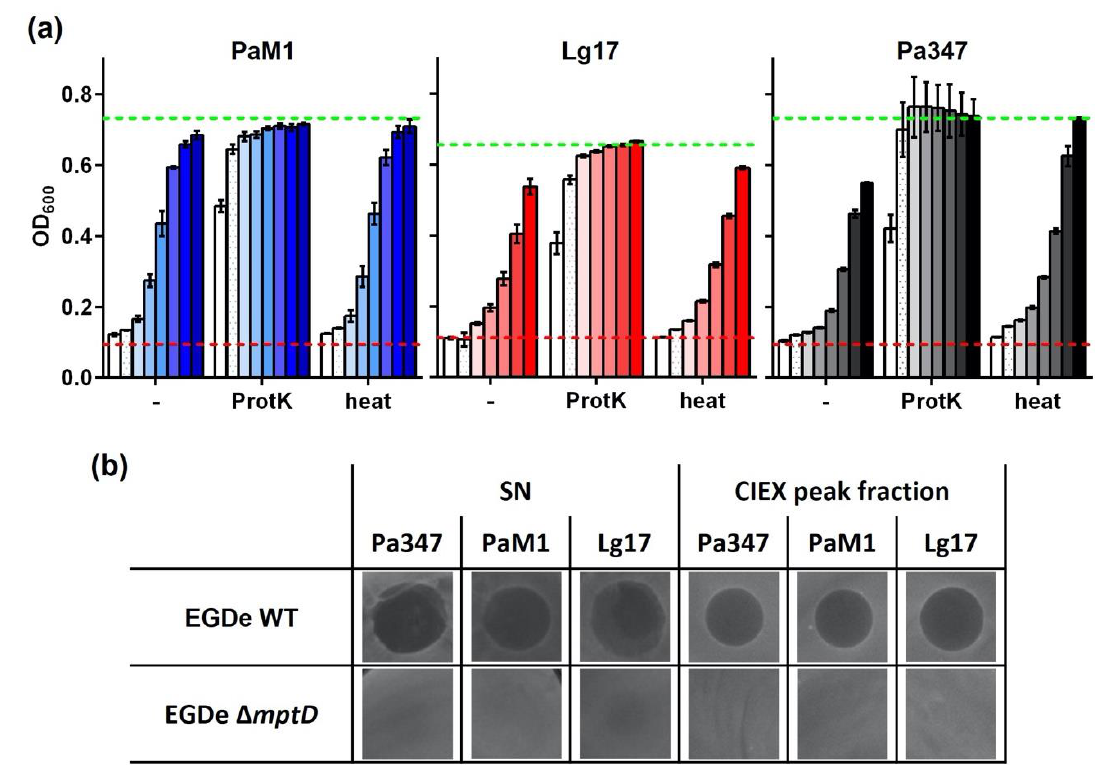
Figure 5. ( a ) Supernatants of P. acidilactici M1 (PaM1) and L. garvieae 17 (Lg17) or P. acidilactici 347 were treated for 3 h with proteinase K (ProtK) or incubated for 30 min at 80 °C (heat) and activity was compared to the untreated control samples (-). Dilutions were 1:8 – 1:1024 and are indicated by a color scale with increasing intensity. Values are OD 600 of the indicator strain and are mean ± standard deviation ( b ) of n = 3 experiments. The broken red and green lines indicate OD 600 of the positive (i.e., complete inhibition of growth) or negative (i.e., sterile MRS medium) controls, respectively. ( b ) Spot-on-lawn assays to determine antimicrobial activity in cell-free culture supernatants (SN) or peak fractions collected during CIEX chromatography of ammonium sulfate-precipitated supernatant proteins (shown in Figure 4a) using either L. monocyto- genes EGDe wildtype (EGDe WT) or its isogenic mutant EGY2 with an 84 bp deletion in the mptD gene ( EGDe Δ mptD ).